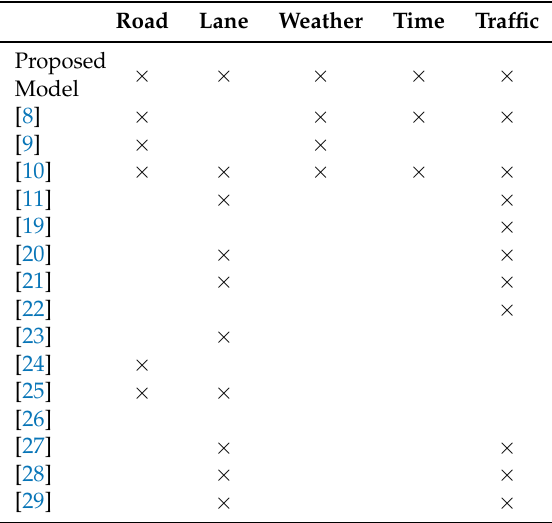
Table 15. Environmental factors comparison.